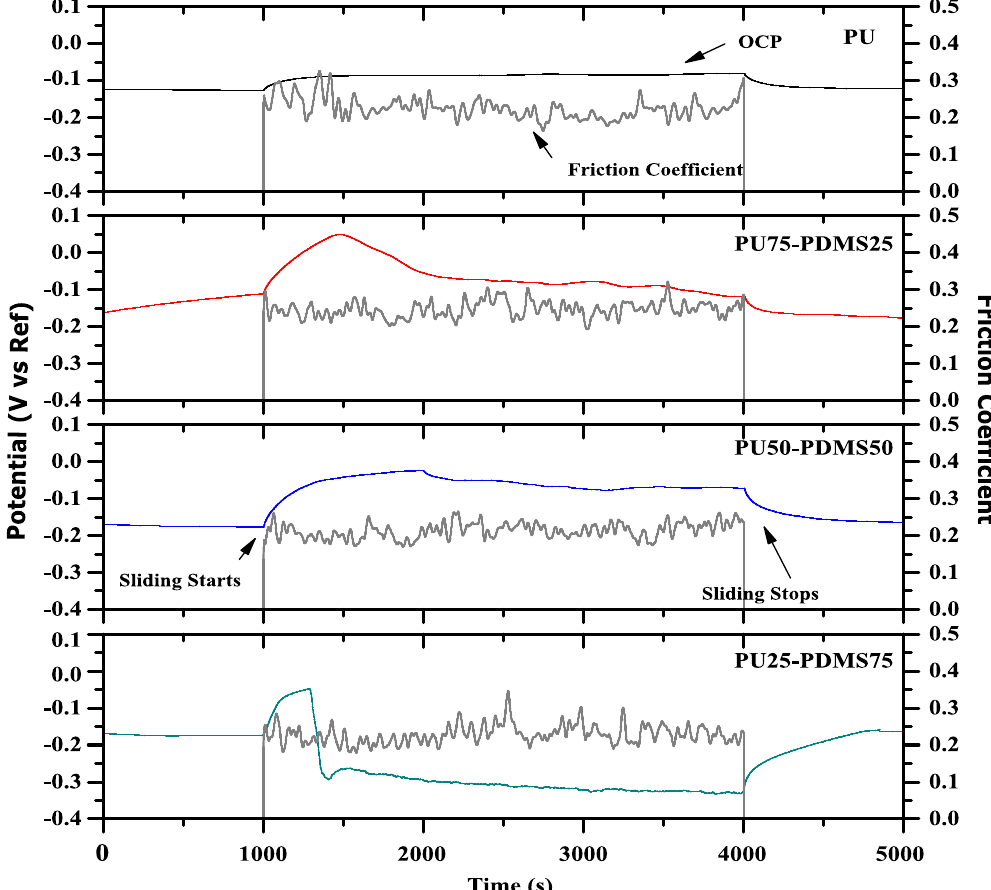
Figure 10: OCP wear of AISI 316L coated with PU – PDMS polymers in Ringer ’ s